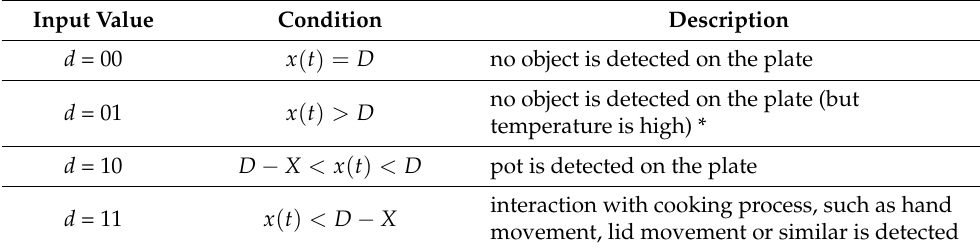
Table 1. Values of the distance parameter d